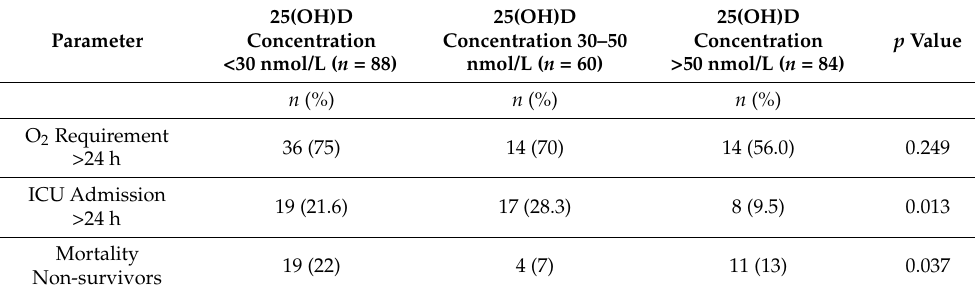
Table 3. Clinical outcomes of patients according to vitamin D status ( n = 232).